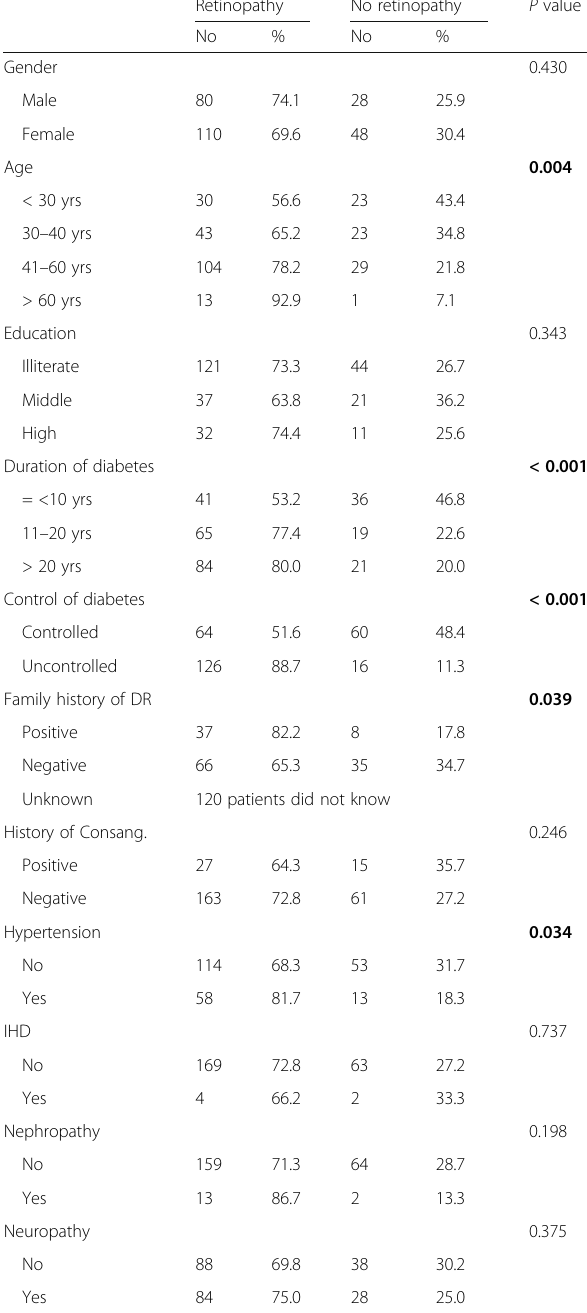
Table 1 Clinical characteristics of patients grouped according to the presence of